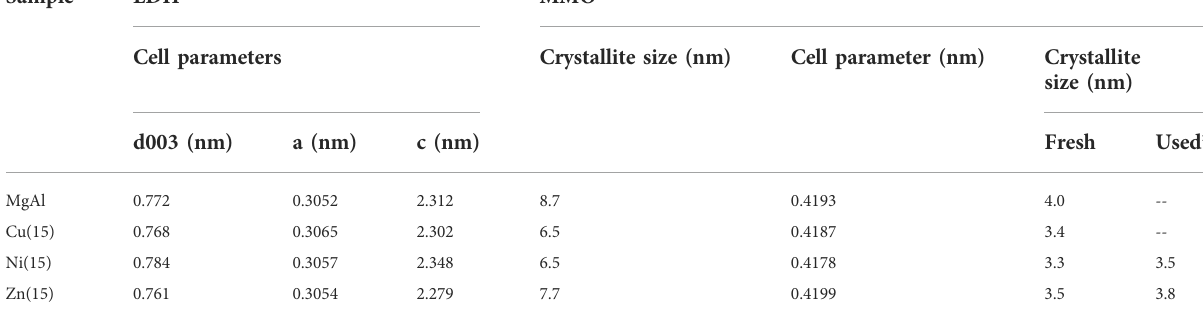
TABLE 1 Cell parameters and morphology of the materials.